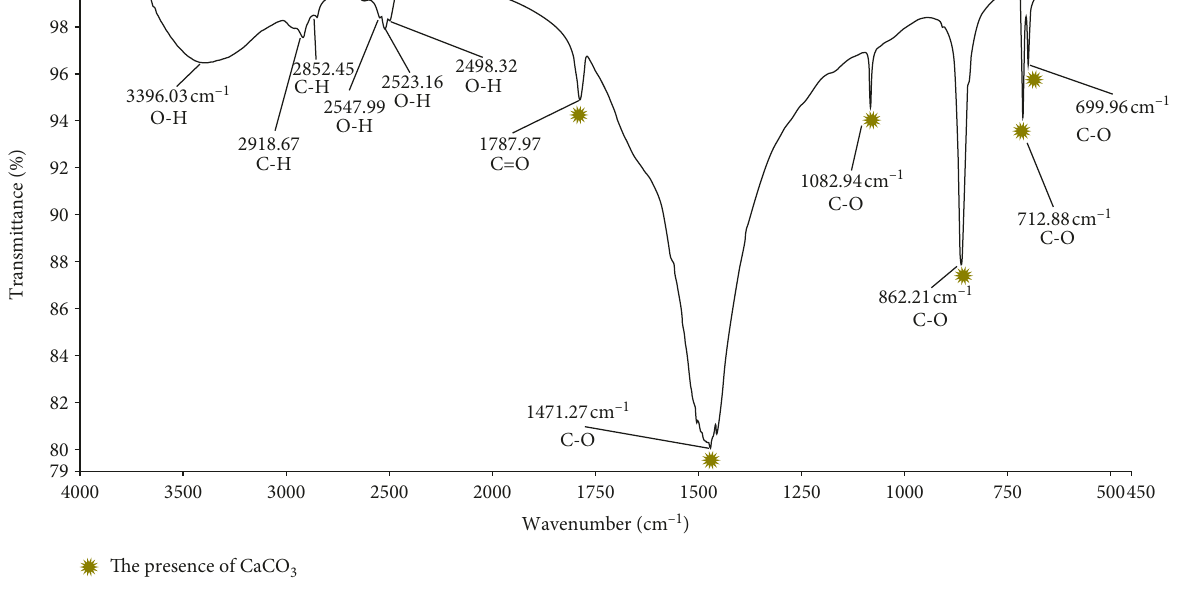
Figure 3: FTIR spectrum of FSS.